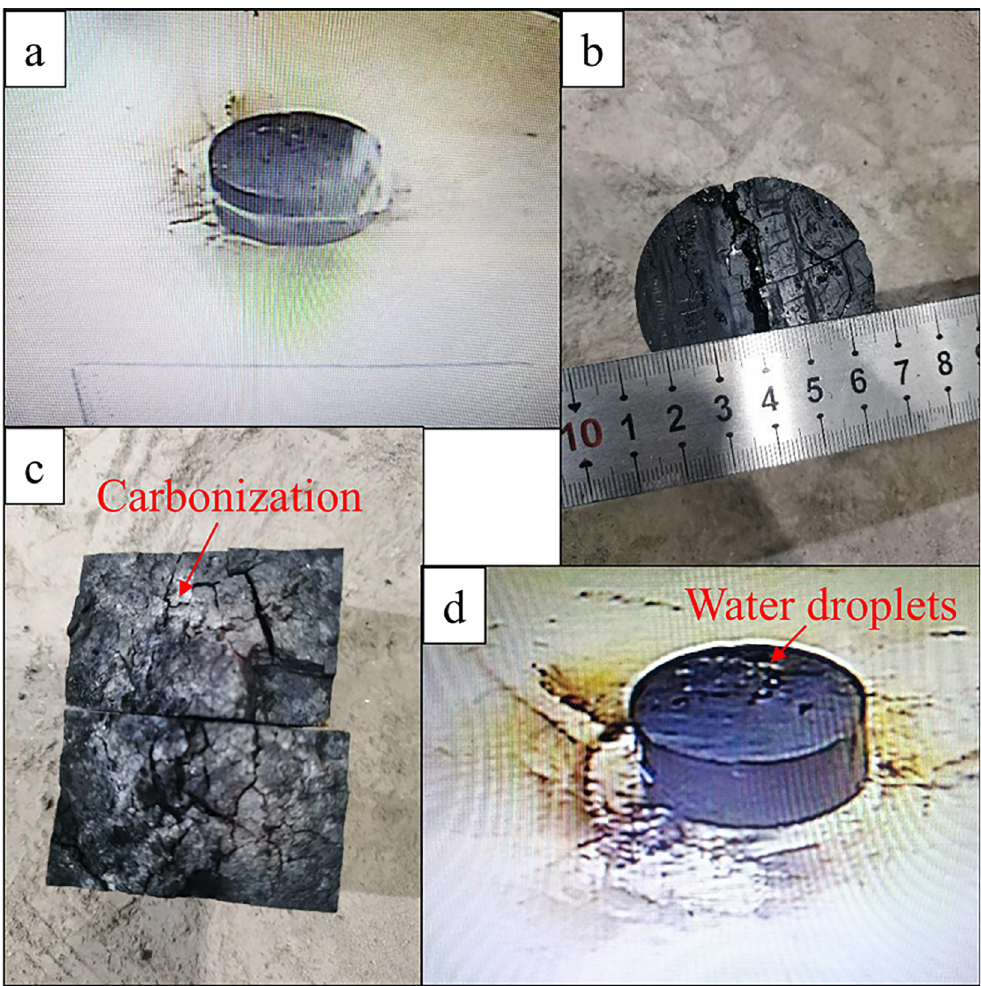
Fig 5. Microwave ignition of coal